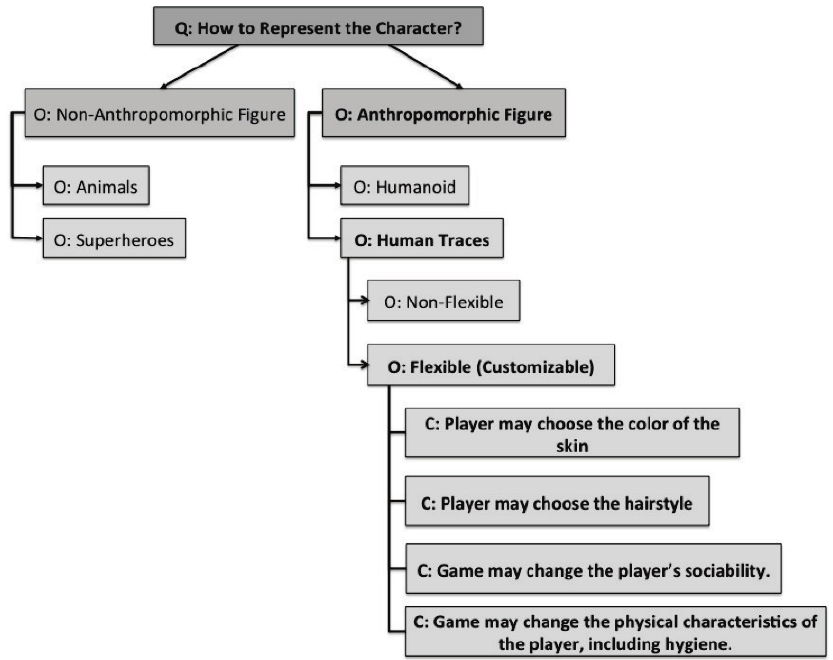
Fig. 10. DR regarding the decisions of how to represent the game for chemical dependent patients. Bold text show the chosen options.